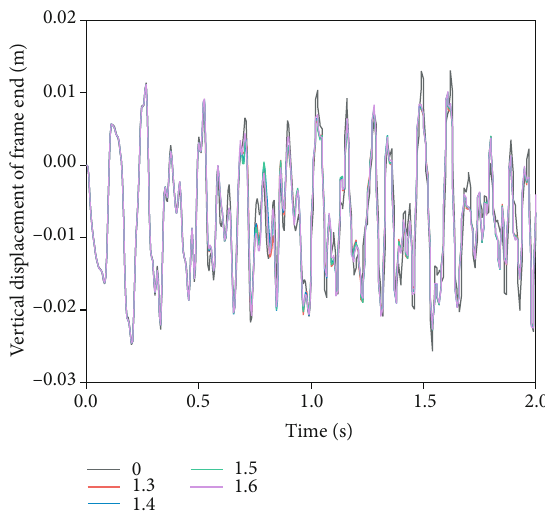
Figure 11: Vertical displacement of the frame under di ff erent ejection forces with airborne